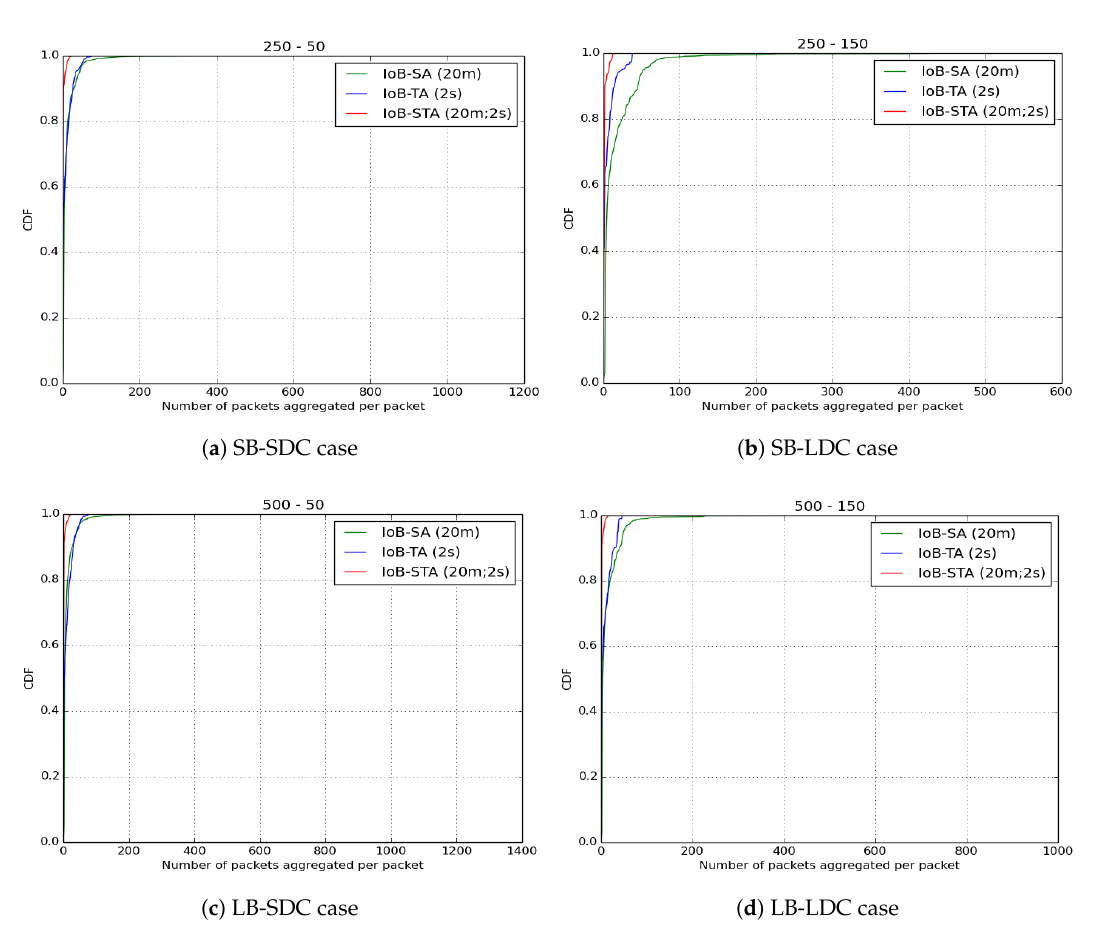
Figure 43. Average number of aggregated packets per packet for